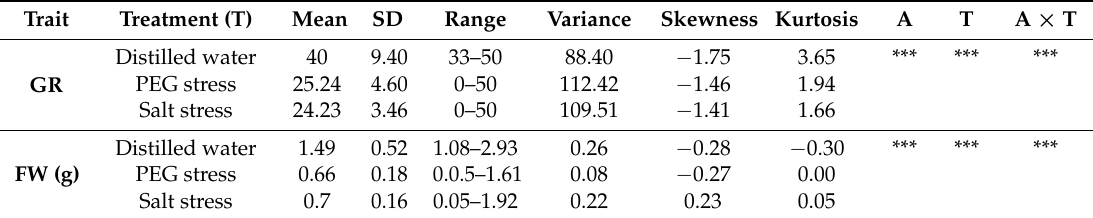
Table 1. Phenotypic variation of GR and FW under control and stress conditions.